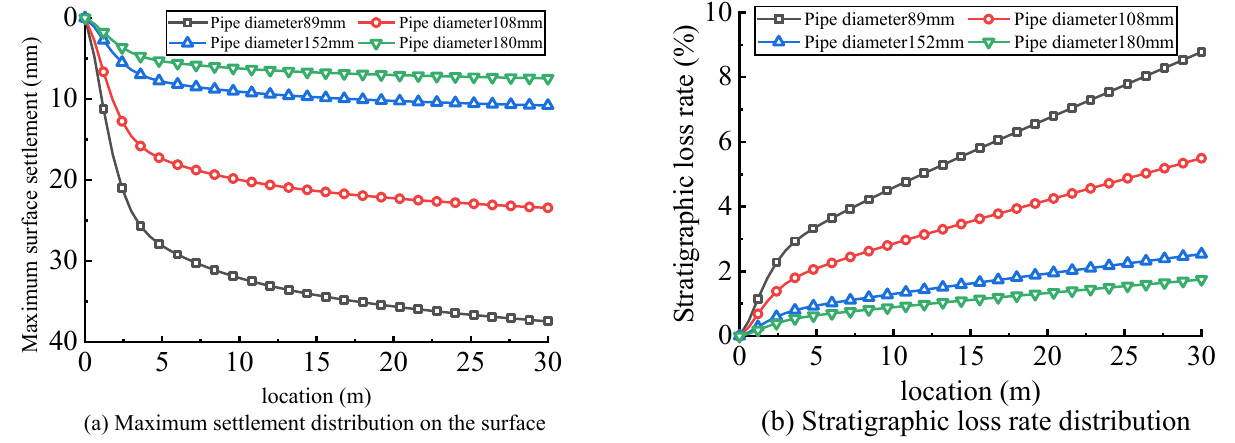
Figure 8. Influence of pipe diameter on formation deformation distribution.